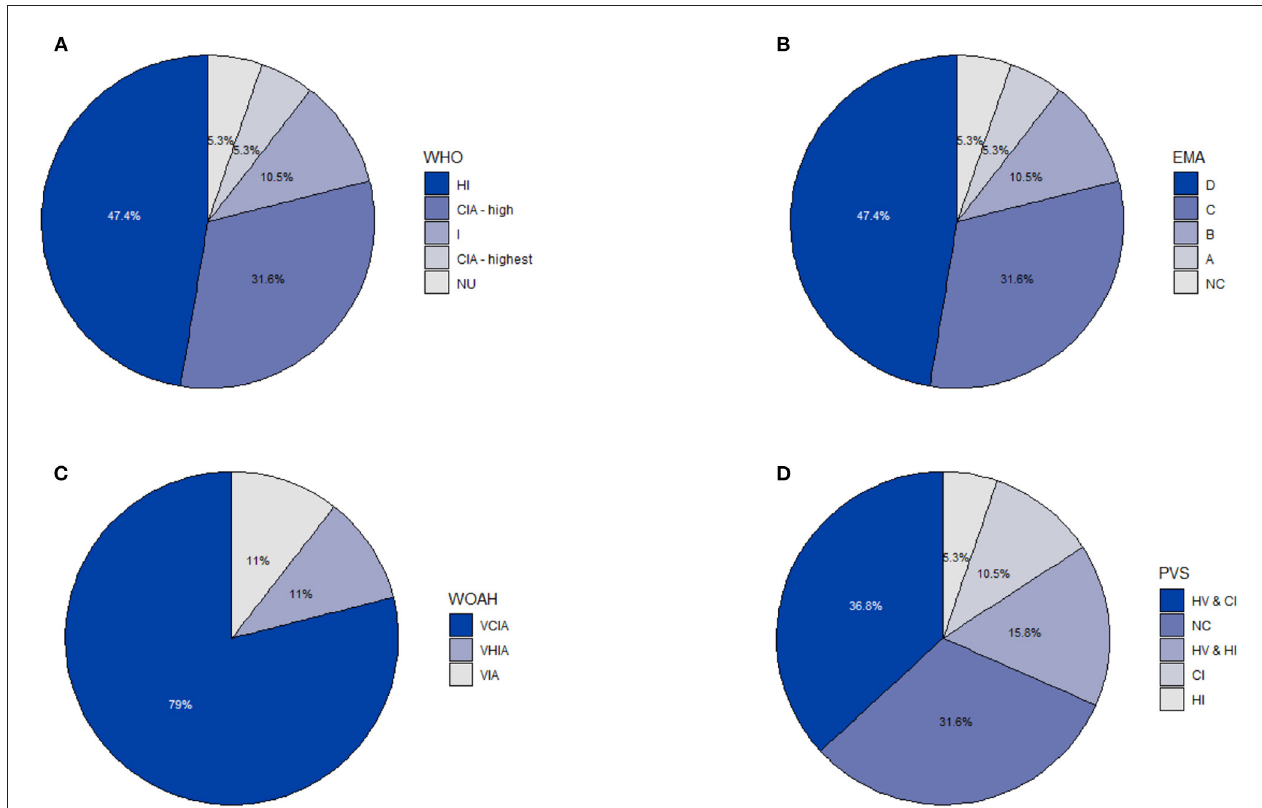
FIGURE 2 | The classification of antibiotic active ingredients on a commercial pig farm in South Africa from 2016 to 2018 according to four different scales (i.e. WHO, EMA, WOAH and PVS) ( n = 19): (A) World Health Organization (WHO) (CIA highest, Highest priority critically important antibiotics; CIA high, high priority critically important antibiotics; HI, highly important antibiotics; I, Important antibiotics; NU, Antibiotic class not currently used in humans). (B) European Medicines Agency (EMA) (A, Avoid; B, Restrict; C, Caution; D, Prudence; NC, No categorization). (C) World Organization for Animal Health (WOAH) (VCIA, Veterinary Critically Important Antibiotic Agents; VHIA, Veterinary Highly Important Antibiotic Agents; VIA, Veterinary Important Antibiotic Agents). (D) Pig Veterinary Society of the South African Veterinary Association (PVS) (CI, human critically important; HI, human highly important; HV, human and veterinary; NC, No